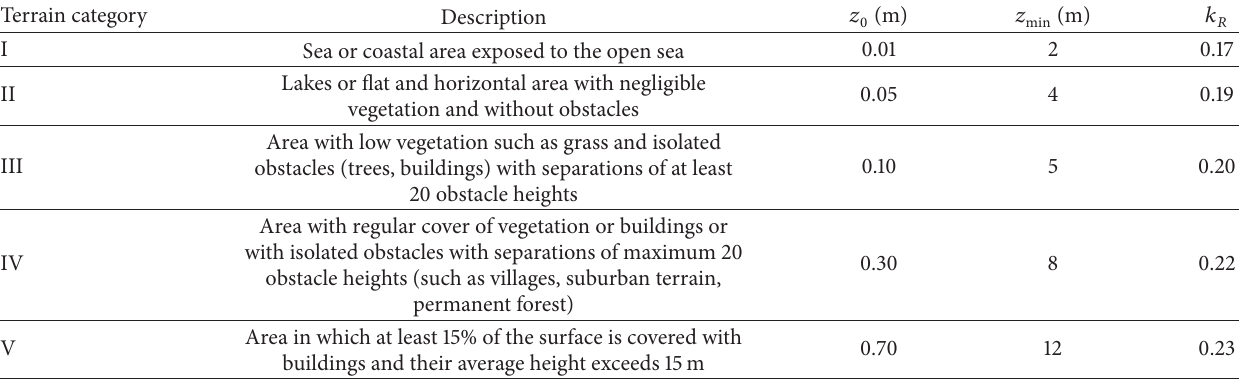
Table 1: Terrain categories as defined by Eurocode 1 [16] and corresponding roughness length 𝑧 0 , terrain factor 𝑘 𝑅 , and parameter 𝑧 min according to the Italian technical standard